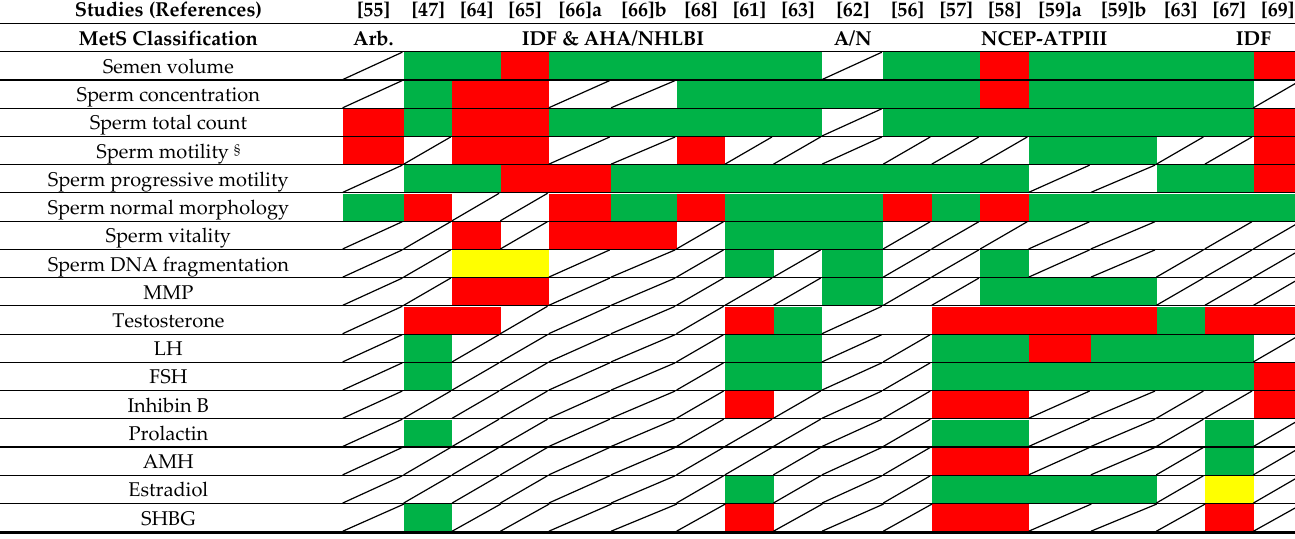
Figure 1. Comparison of metabolic syndrome (MetS) prevalence in fertile and infertile men derived from the database of the Andrology Unit of the University of Florence, according to IDF&AHA/NHLBI ( A ) and NCEP-ATPIII ( B ) criteria. * p < 0.05.